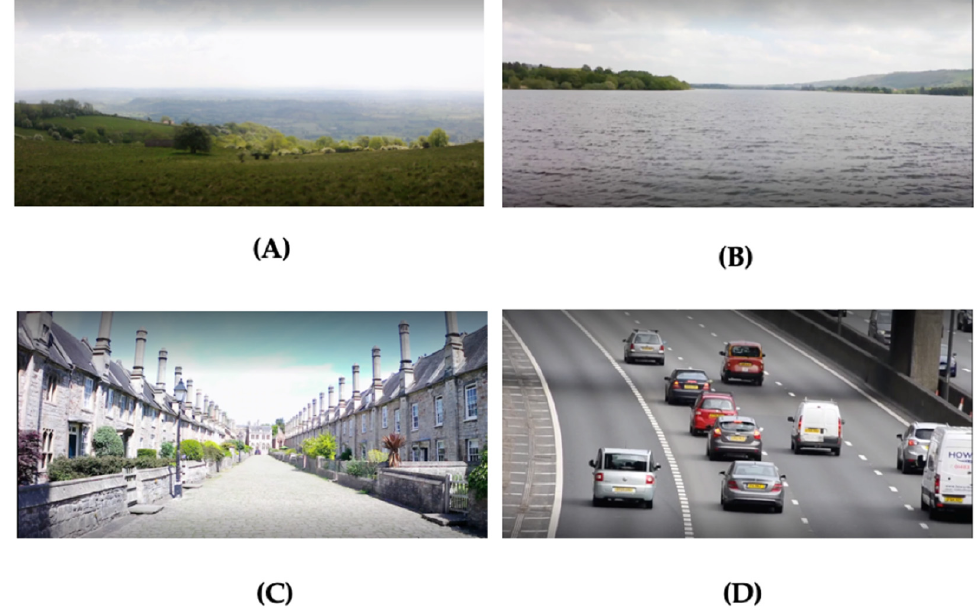
Figure 2. Visual stimuli. ( A ) Green environment; ( B ) Blue environment; ( C ) Historic environment; ( D ) Traffic.